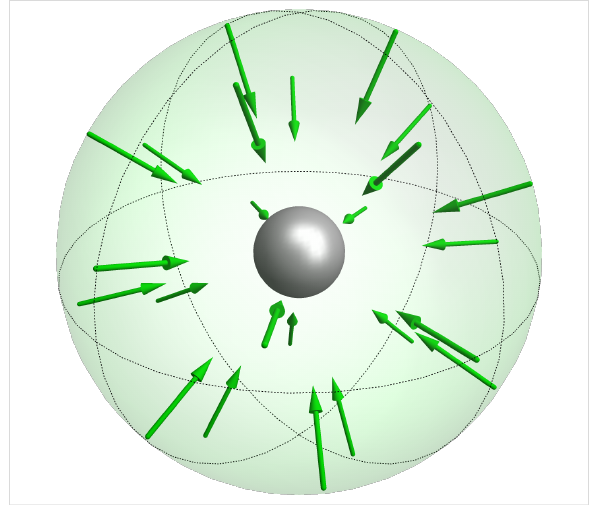
Figure 1: Single sphere with multiple plane wave illuminations, depicted with their wave vectors in